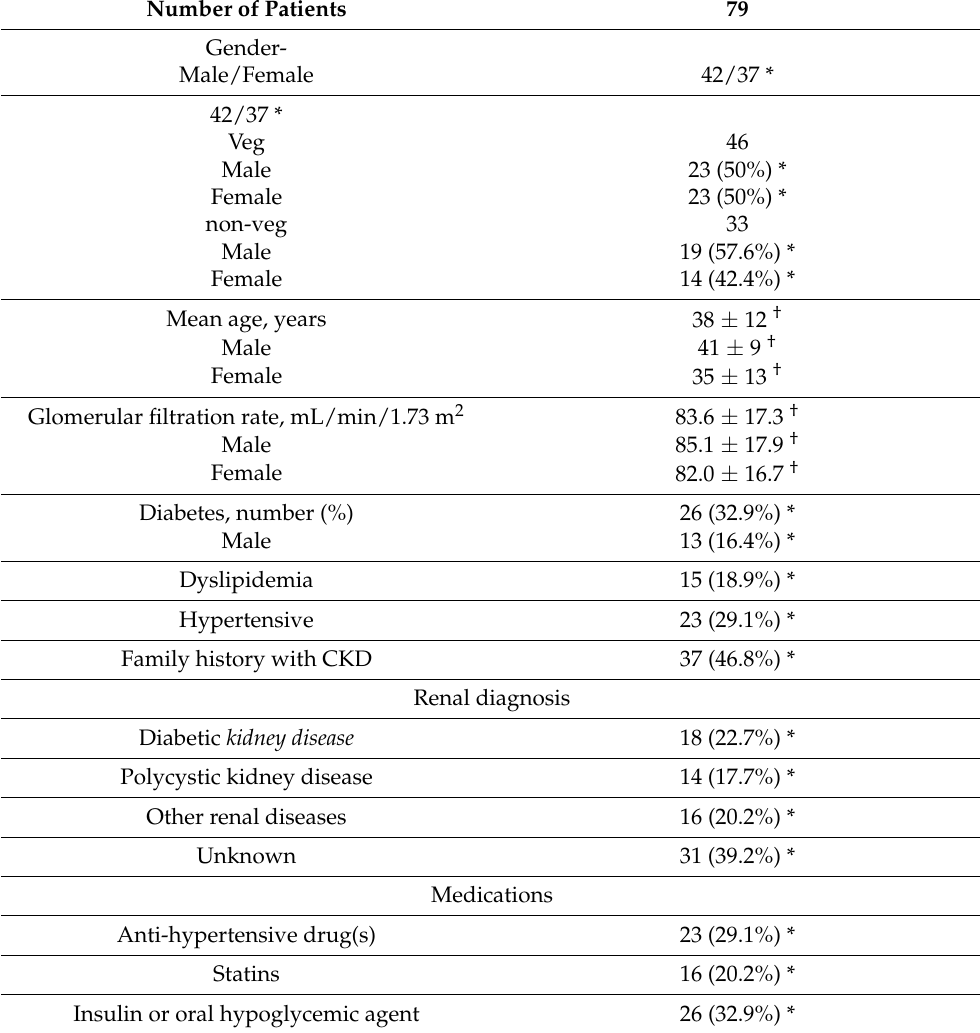
Table 1. Clinical characteristics of CKD patients (n =